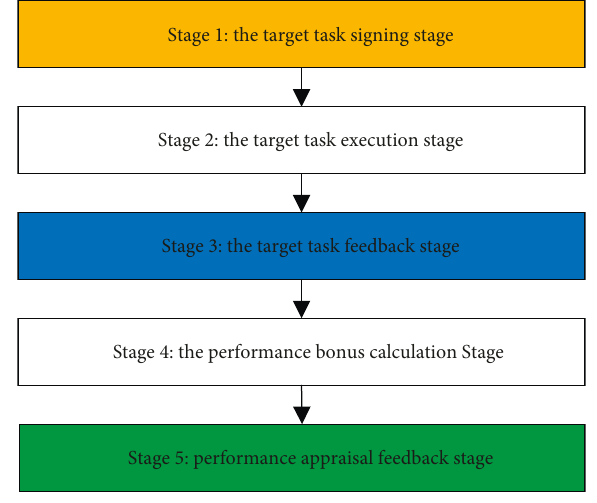
Figure 1: Performance appraisal process for enterprise